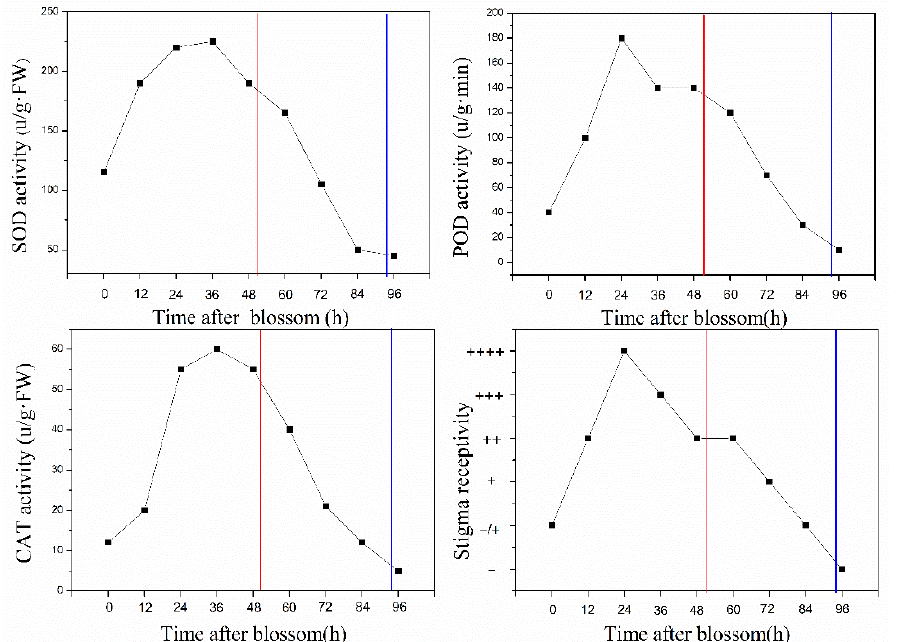
Figure 4. The dynamics of stigma receptivity and activity of POD, SOD and CAT over time after blossom. “ − ” means the stigma is not receptive; “ − /+” means that some of the stigmas are receptive; “+” means the stigma is receptive, and more “+” symbols mean the stigma is strongly receptive. The red vertical lines refer to time of natural corolla abscission, and the blue vertical lines refer to time of corolla abscission after anti-robbing.